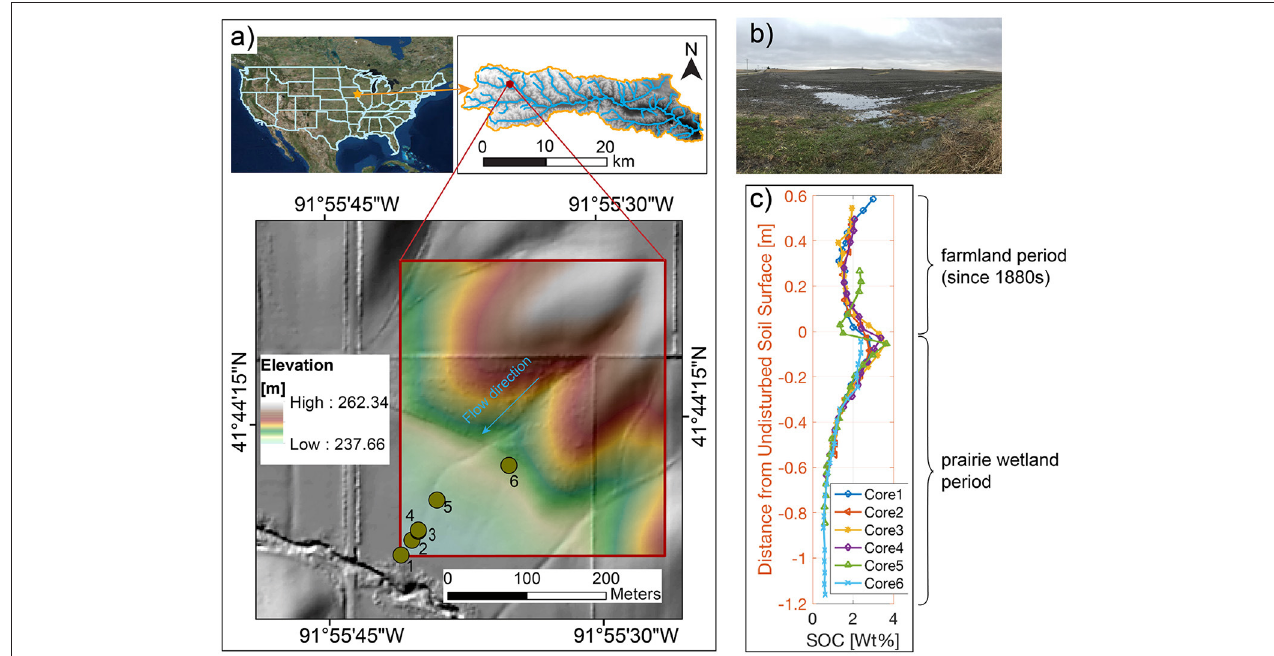
FIGURE 1 | Study site and core sampling (adapted from Yan et al., 2019) with permission from Wiley. (a) Study site and 2 m digital elevation model (DEM). The six dots are locations where soil-core samples are collected. (b) The field view. (c) The SOC concentration profiles of the six cores that have been realigned so that zero depth corresponds to estimated pre-industrial agricultural period. The six profiles with re-alignment show a “nose” below the surface in the depositional sites. The “nose” is a result of the burial of legacy carbon due to accelerated deposition of soils after European Settlement and associated SOC mobilized from upland erosion.